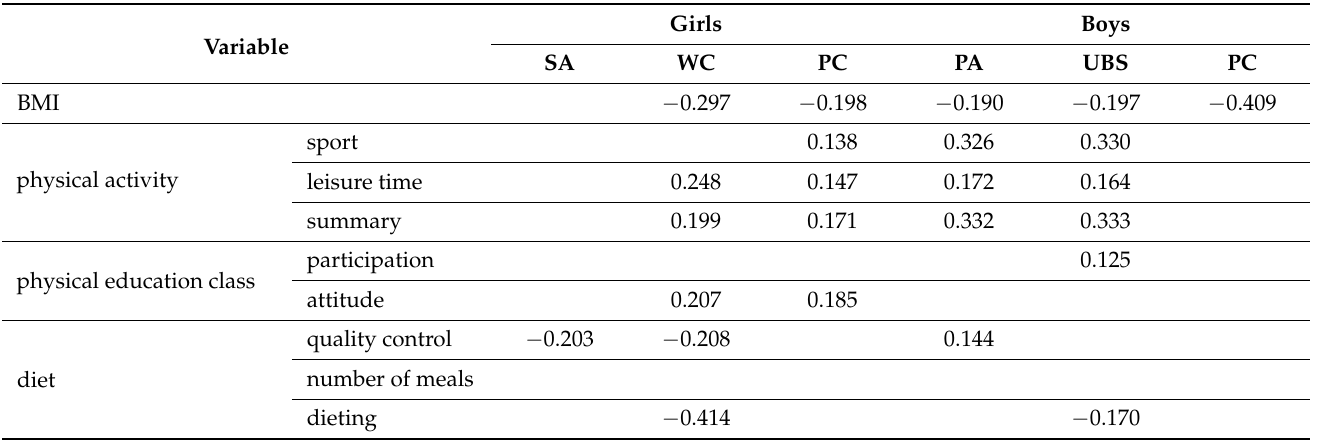
Table 2. Correlation between the analyzed variables and the BES